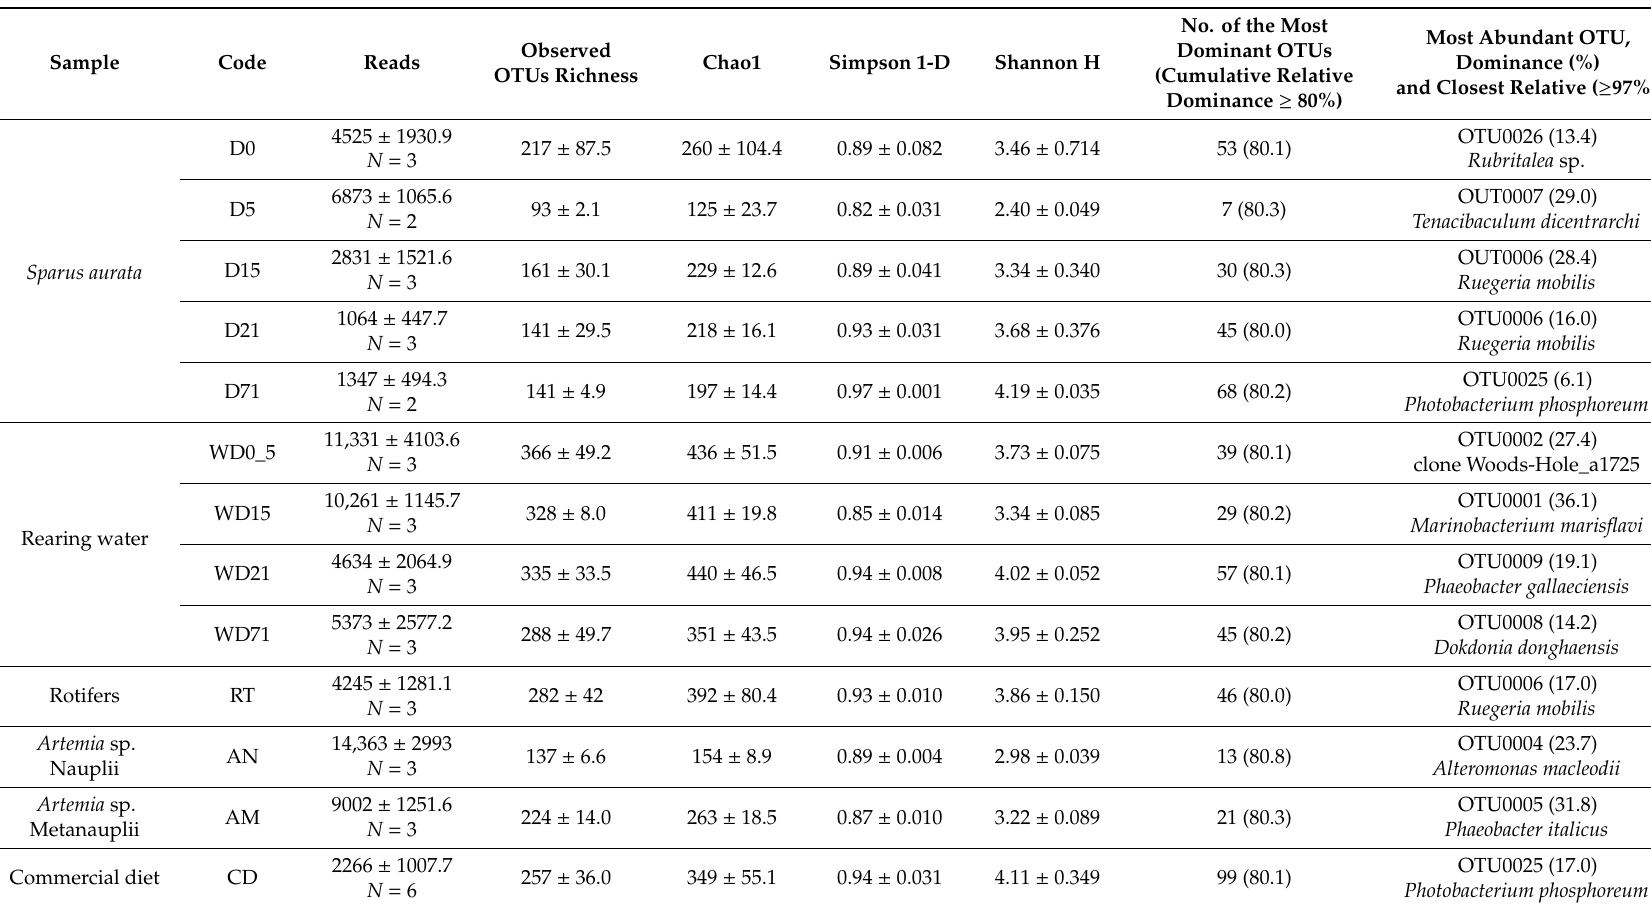
Table 1. Pyrosequencing results of 16S rRNA gene diversity reported in each sample group. N: Number of biological replicates analyzed, D: Day, OTUs: Operational taxonomic